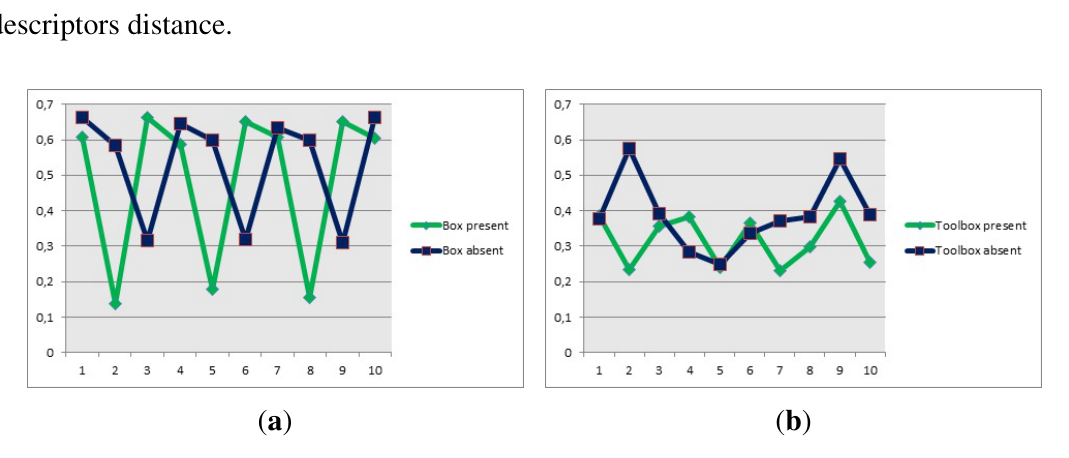
Figure 20. Descriptors distance. ( a ) Box descriptors distance; and ( b )